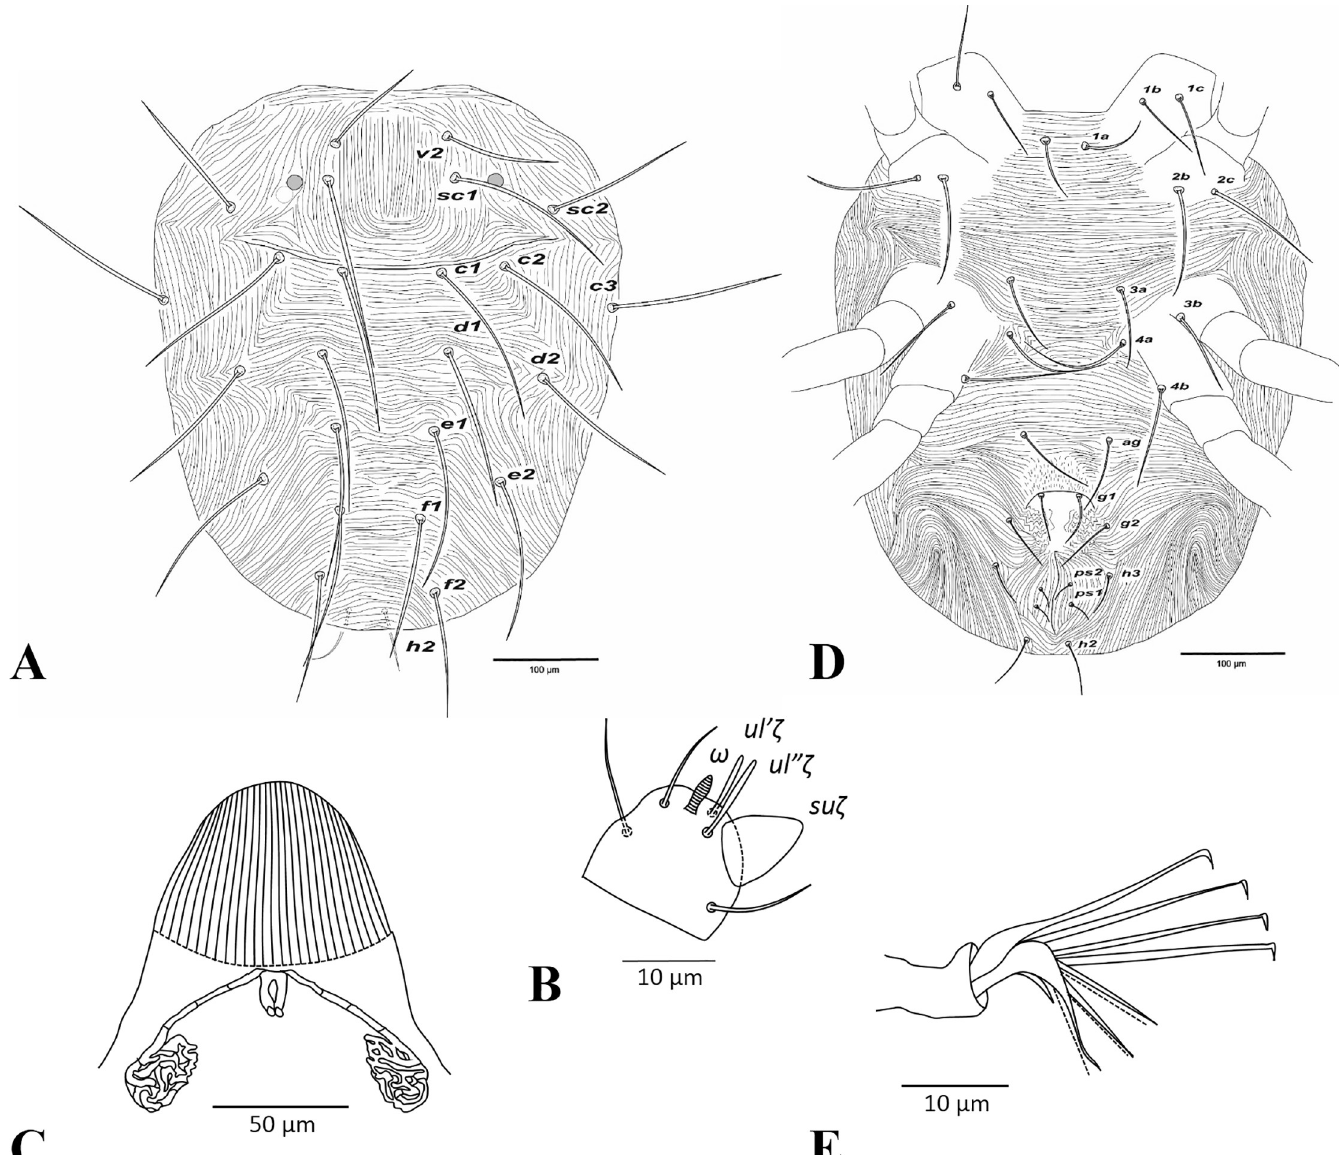
Fig 7. Amphitetranychus viennensis , female—A. Dorsum, B. Distal segment of palpus, C. Peritremes, D. Venter, E. Empodium of leg I.